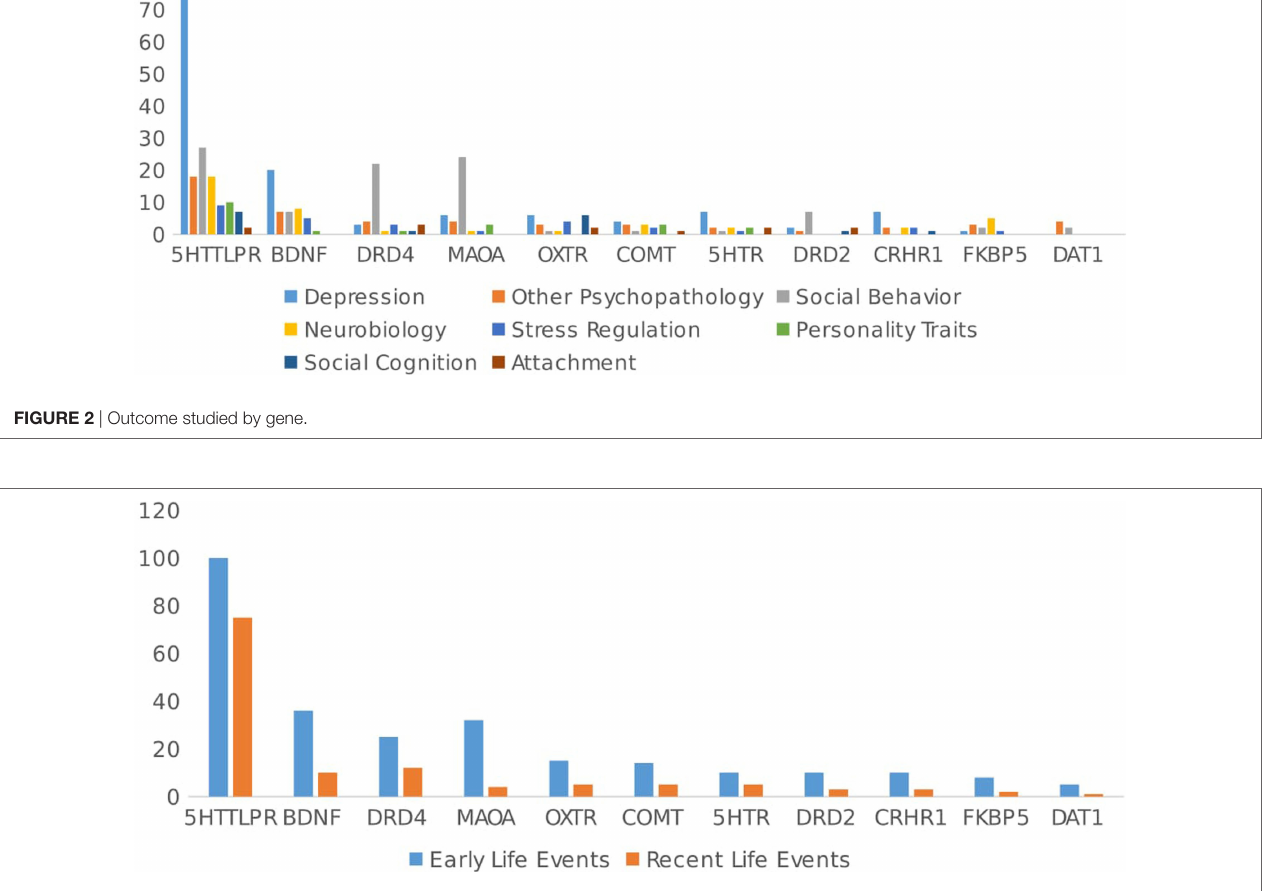
FiGURe 3 | Type of environment studied (early vs. recent life events) by